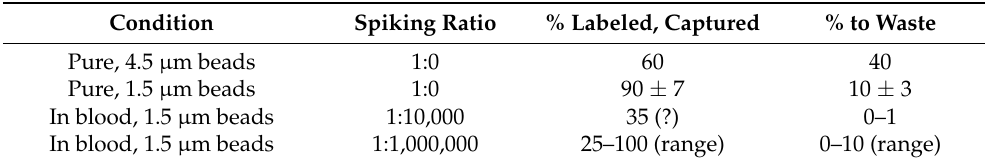
Table 3. Summary of results of determination of labeling and capture efficiency of pure melanoma cells and cells spiked into whole